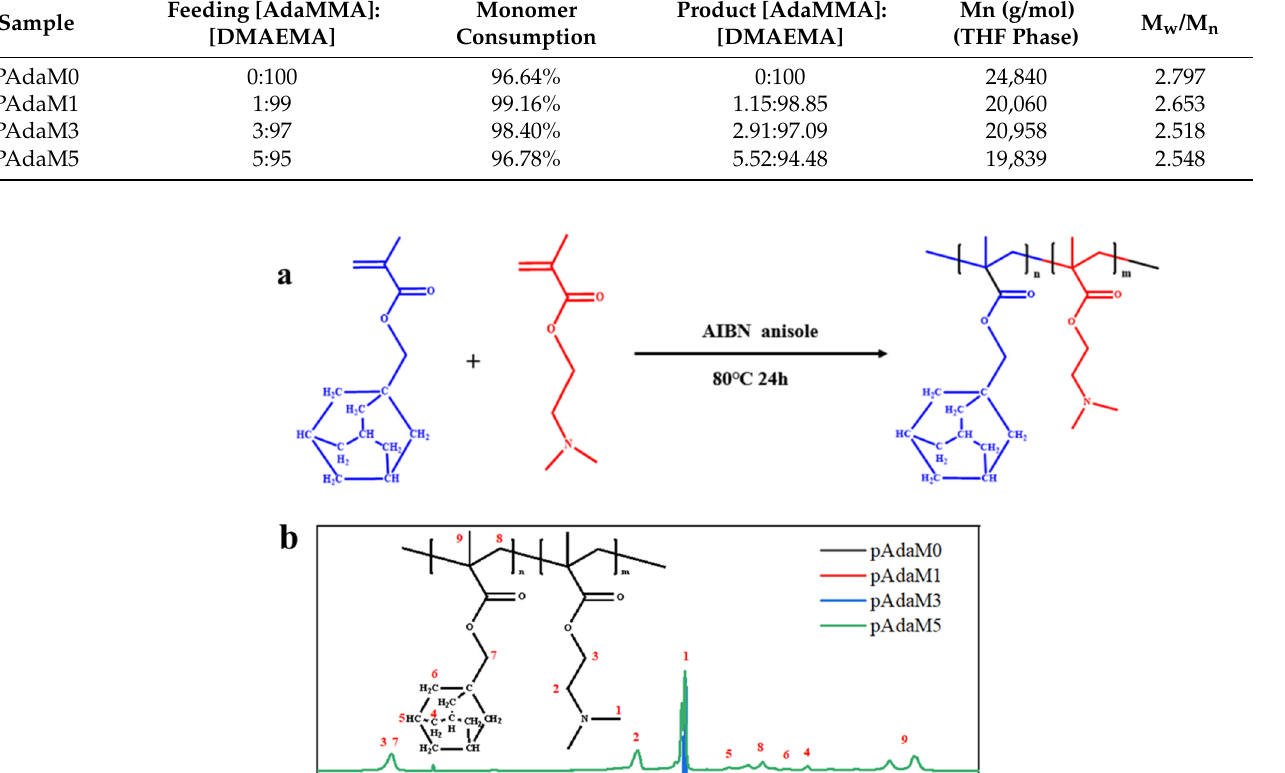
Table 1. The summary of the structure of PAdaMX with different [AdaMMA]:[DMAEMA] feed ratios. Sample